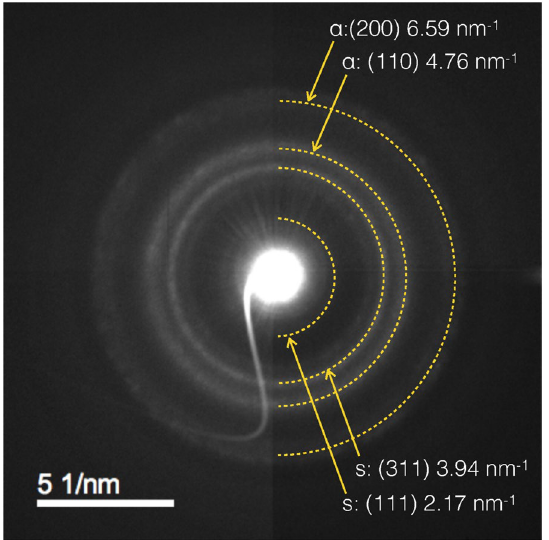
Figure 3. Electron diffraction. Selective-area electron diffraction of the region depicted by a green circle in Fig. 2(a). The dotted lines indicate the positions of the diffraction rings associated with the Co-Fe bcc phase ( α ) and the Co 2 FeO 4 spinel phase